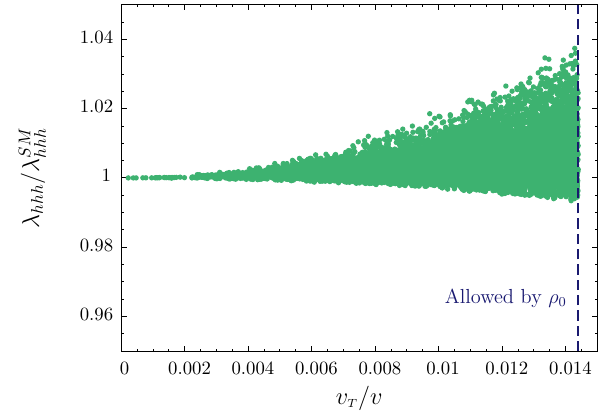
Fig. 7 The modification of the trilinear Higgs self-coupling with respect to the SM as a function of v T /v . For all points the minimum (v ,v ) is the global H T